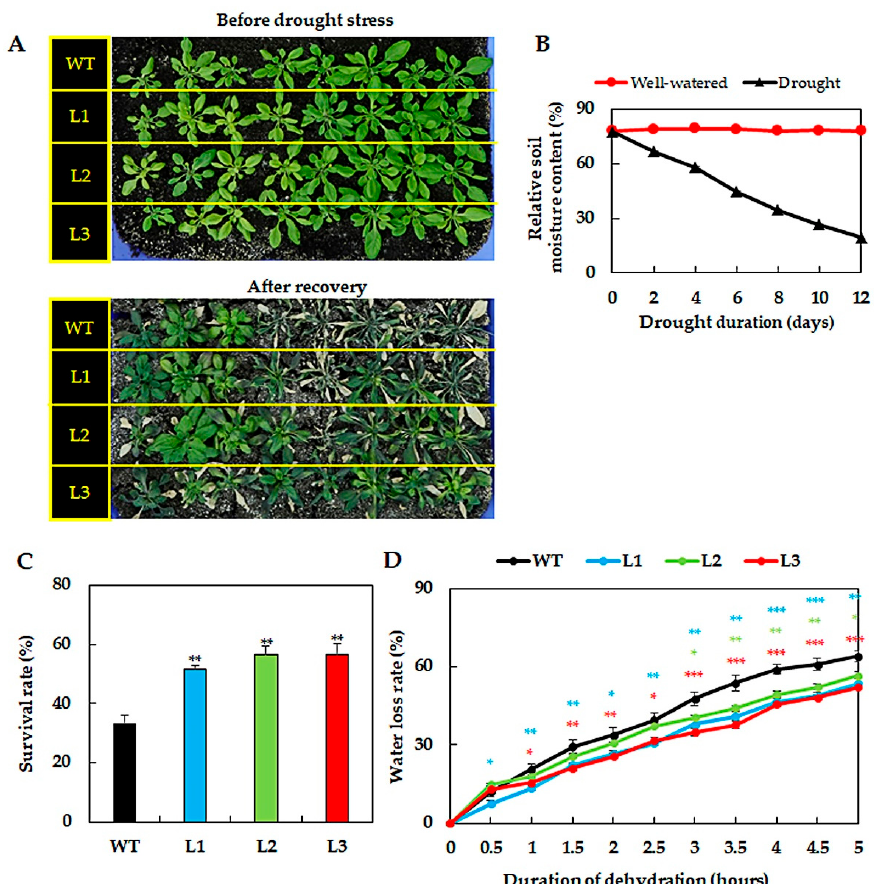
Figure 2. Drought tolerance evaluation of GmNAC019 -transgenic Arabidopsis plants based on drought survival rate and water loss rate. ( A ) Photographs of wild-type (WT) and three independent transgenic lines (L1, L2 and L3) before drought treatment and after 12-day soil-drying followed by a 3-day re-watering application. Four-week-old plants were subjected to drought treatment. ( B ) Average relative soil moisture contents that were measured over the course of drought treatment ( n = 6). ( C ) Plant survival percentages after recovery ( n = 3). ( D ) Average water loss rates in leaves excised from four-week-old plants over the course of 5-h dehydration ( n = 9). Error bars represent SEs. Asterisks indicate significant differences (* p -value < 0.05; ** p -value < 0.01; *** p -value < 0.001) between each transgenic line and the WT counterpart at the same treatment conditions, according to a Student’s t -test.